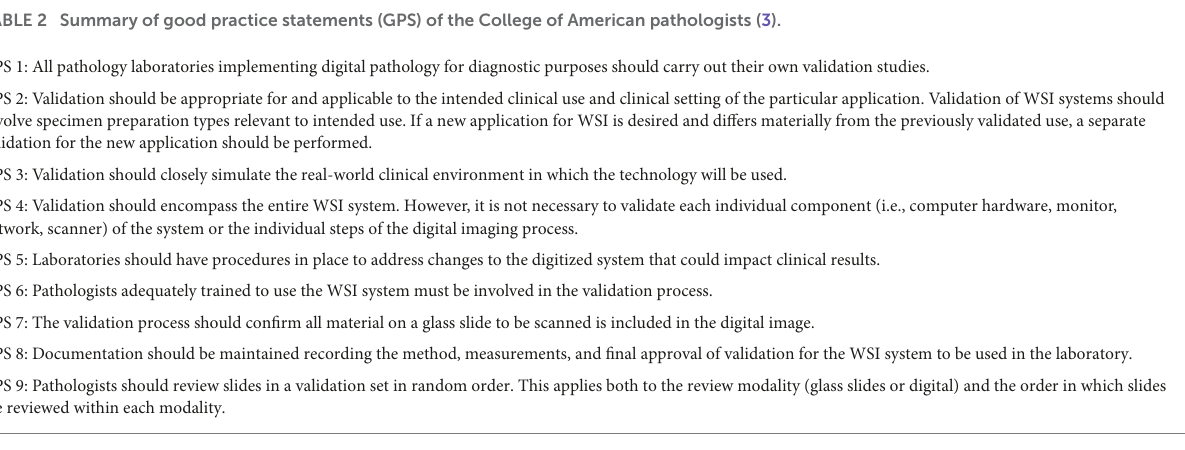
TABLE 2 Summary of good practice statements (GPS) of the College of American pathologists